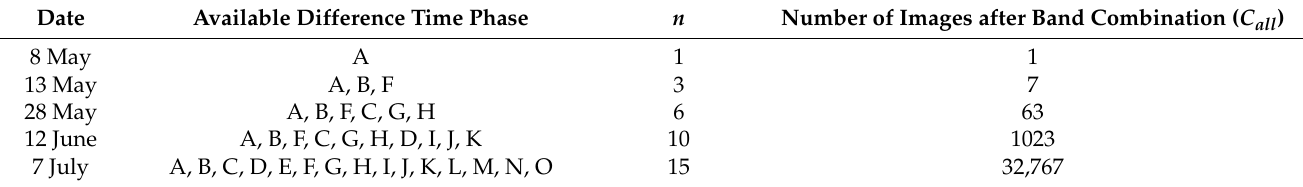
Table 5. Available difference images and total images after band combination for each period in 2020.